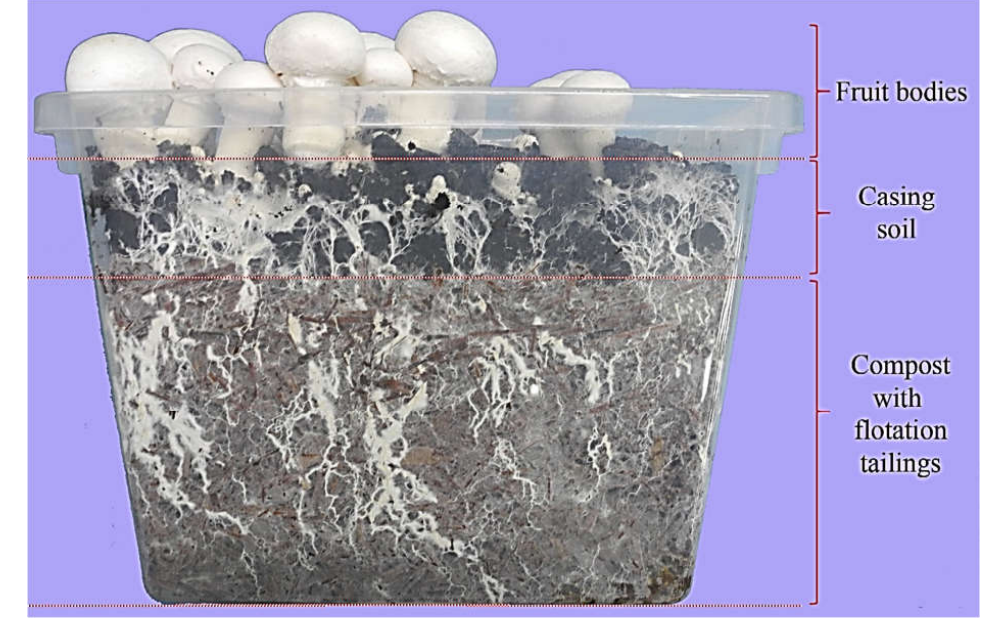
Figure 1. Preparation of experimental systems.